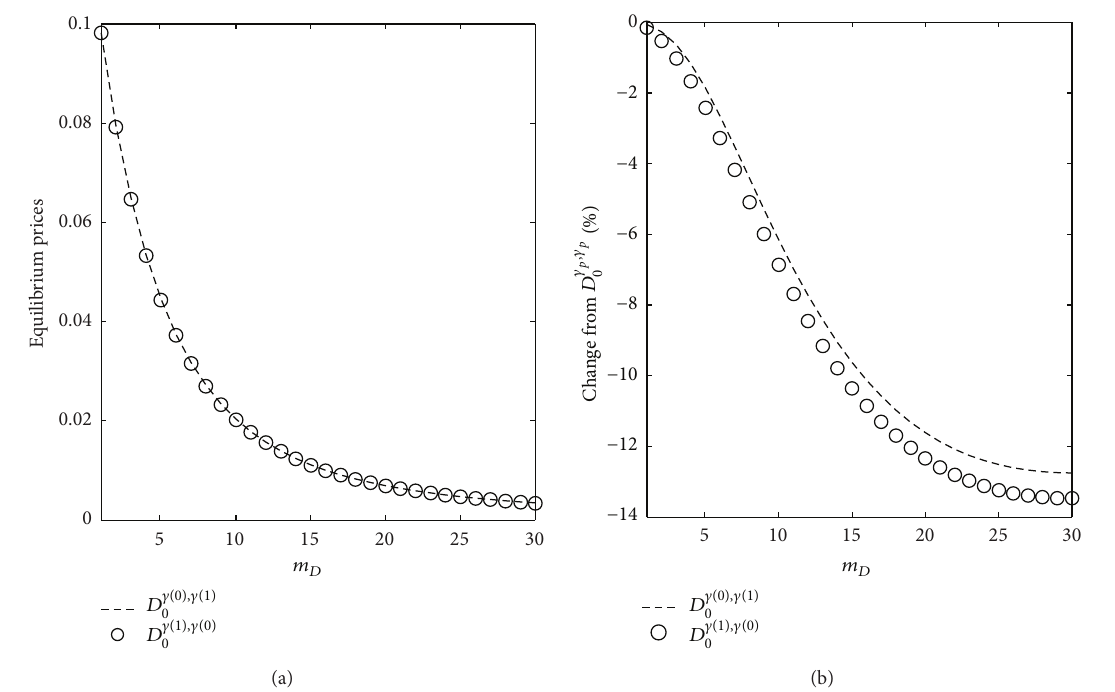
𝛾 𝑝 ,𝛾 𝑝 0 and the subgame perfect equilibrium